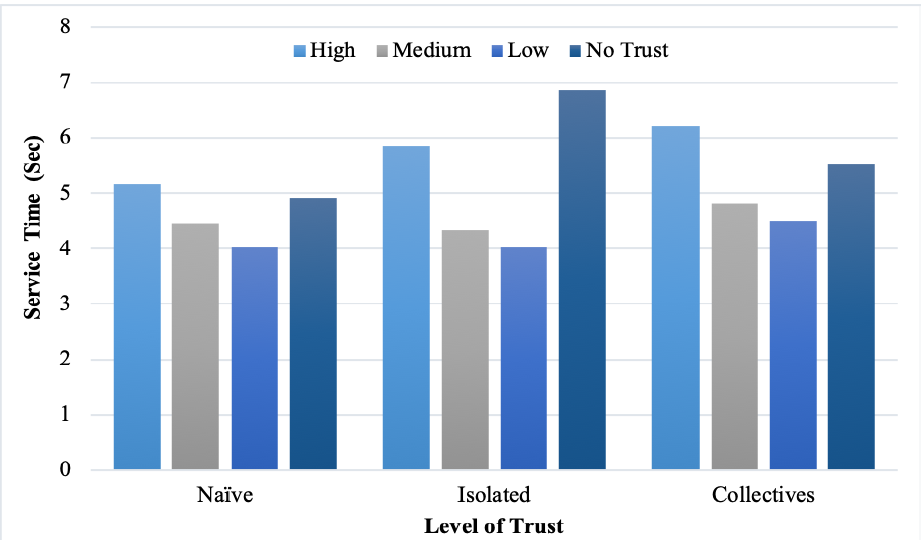
Figure 10. Service time with 50% of malicious.